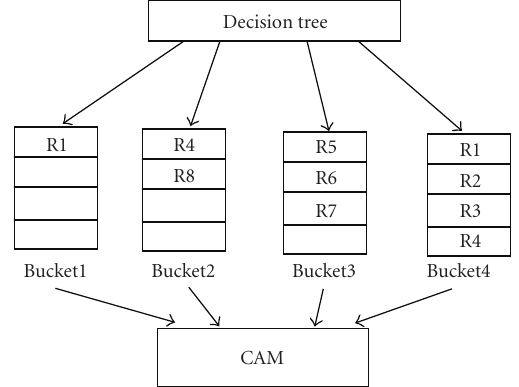
Figure 16: An example to illustrate dynamic updates: rules that cannot be inserted in buckets will be inserted in